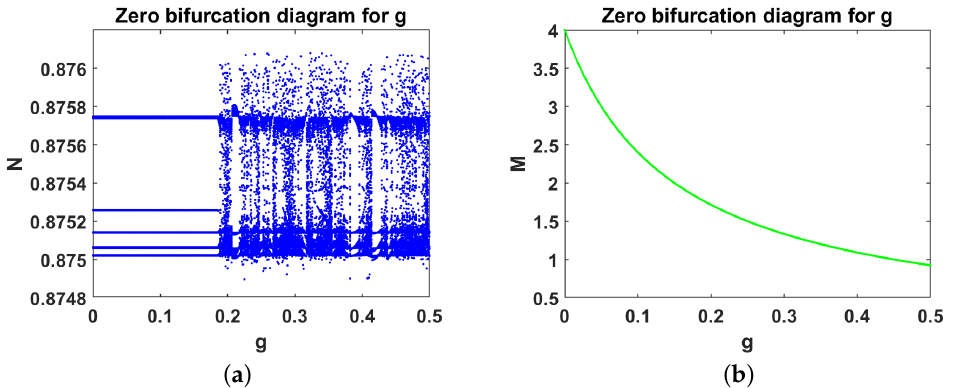
Figure 2. Transcritical bifurcation diagram of model (1) with respect to glucose parameter g where g ∈ ( 0,0.5 ) . ( a ) represents the effect of glucose, g, on the behavior of normal cells denoted by N. ( b ) shows the glucose impact on immune cells denoted by M.